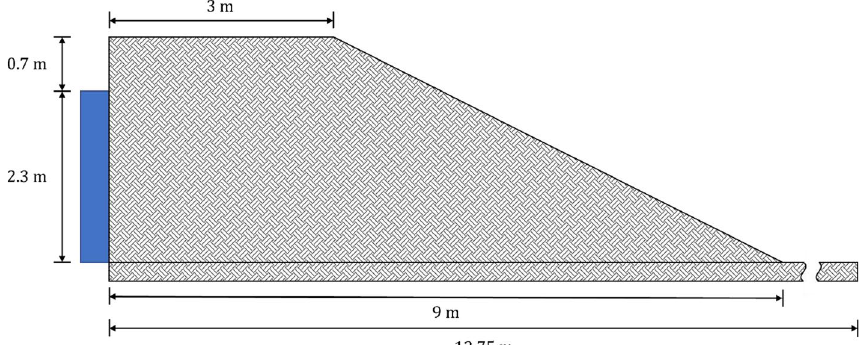
Fig. 17 Levee setup; blue shading on the left is the water table (modeled as a pressure boundary condition); the hatched pattern represents sandy